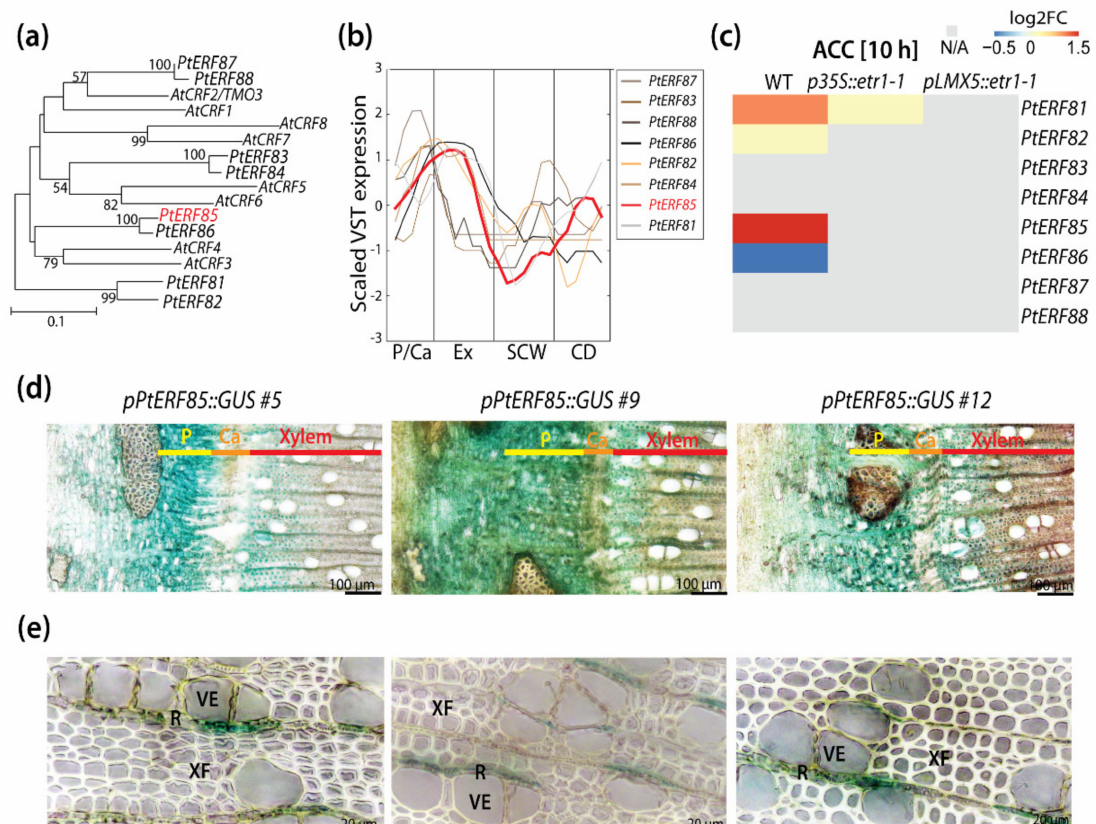
Figure 1. Expression of PtERF85 was observed during cambial growth and the expansion of xylem cells. ( a ) Phylogenetic tree of PtCRFs (cluster VI; PtERF81-PtERF88) and their homologs in A. thaliana (At) (modified from [15]). ( b ) Expression profile of PtCRFs in aspen stems. Data (shown for one representative tree (T1)) was obtained from the transcriptome atlas AspWood [3]. To emphasize expression differences, scaled and smoothened VST expression values (implemented function in http://popgenie.org, last accessed on 19 November 2019) are shown. ( c ) Heatmap showing the expression pattern of